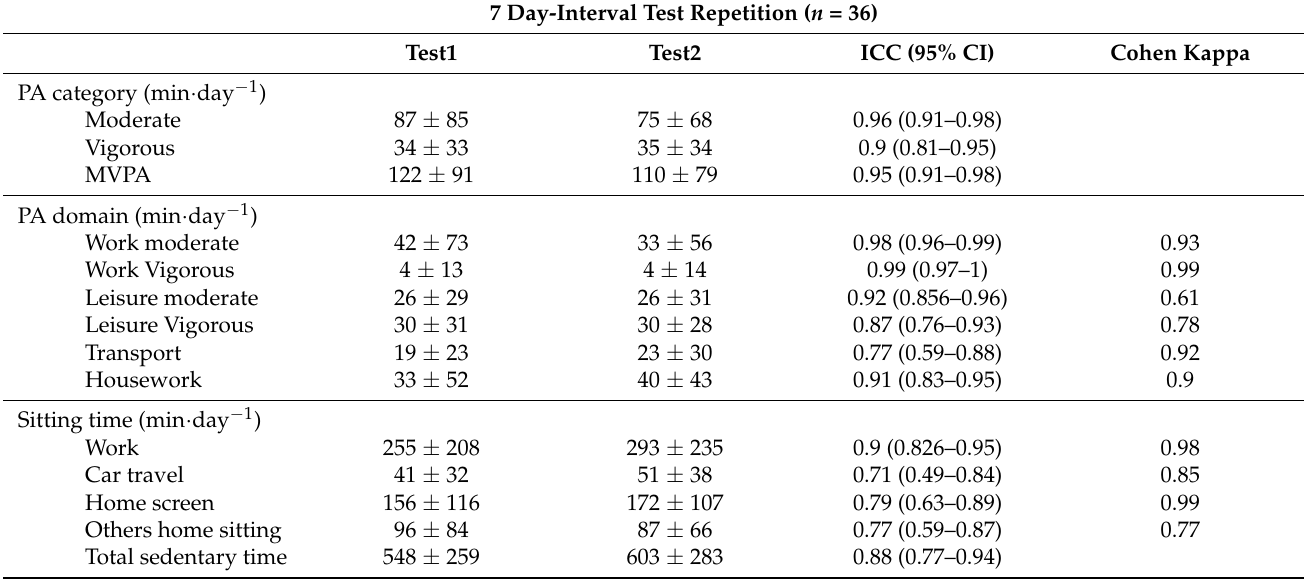
Table 2. Test–retest reliability of the ONAPS-PAQ by activity intensity and physical activity domains with two repetitions (36 participants). Intraclass correlation coefficients (ICC) for the quantitative physical activity measures comparison and Cohen kappa coefficient for personal concern on practices (yes/no) are reported. 7 Day-Interval Test Repetition ( n =